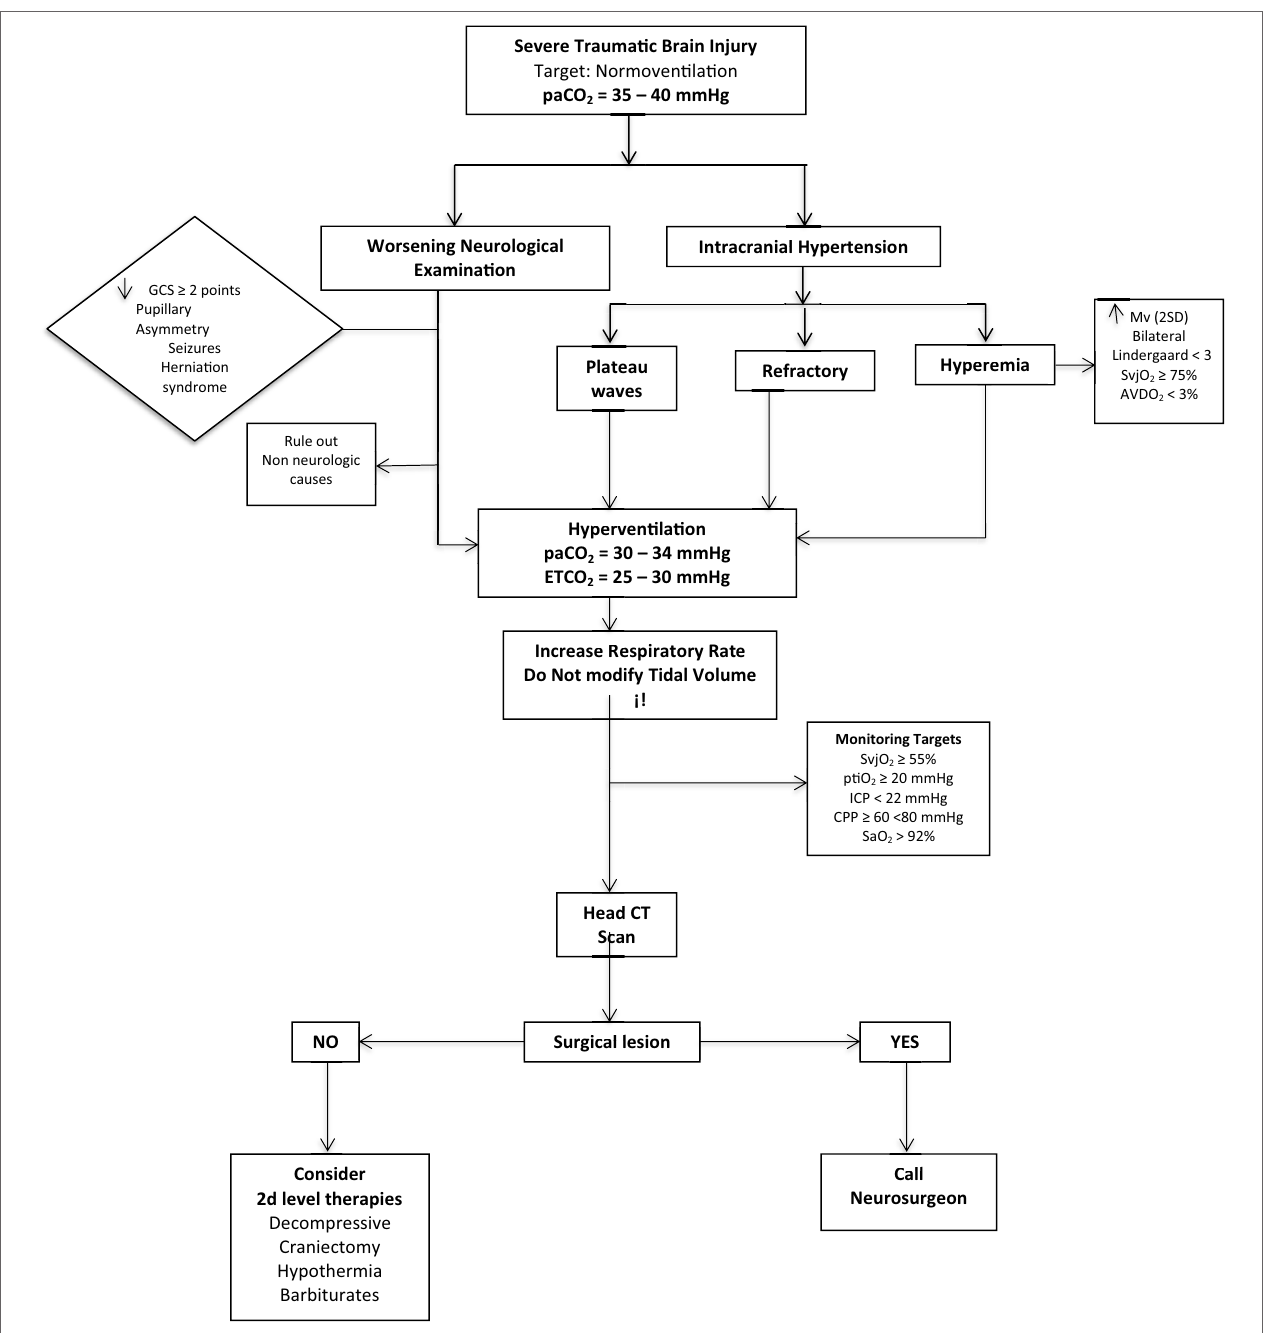
FiGURe 6 | The practical algorithm to perform HV safety. Hyperemia definition: increase in mean velocity (mv) of mean cerebral artery in TCD (TRANSCRANIAL DOPPLER) of more than 2 standard